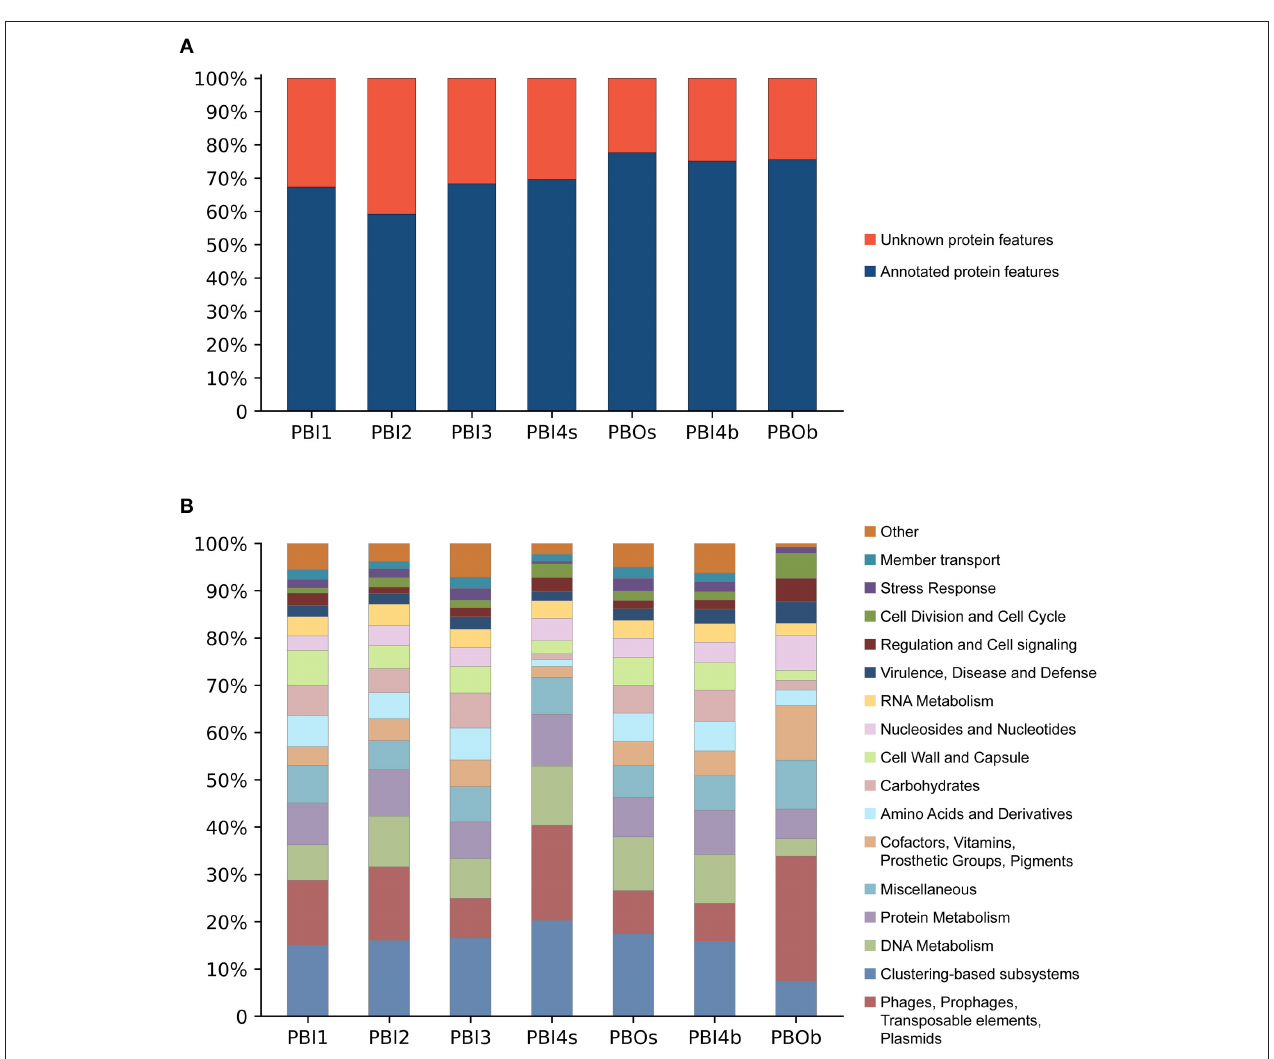
FIGURE 4 | Functional analysis of annotated dsDNA viromes in the Prydz Bay, Antarctic. (A) Total predicted protein features of annotated dsDNA viromes and (B) the different subsystems categories of annotated protein features. Different colors refer to different functions showed in the legend on the right